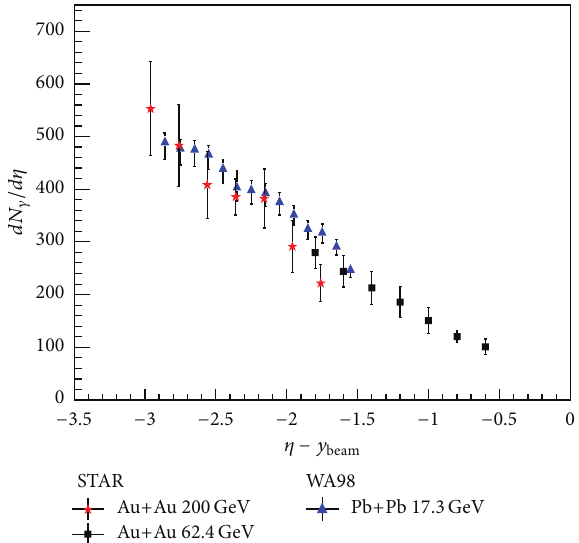
Figure 30: Photon multiplicity density normalized per participant pair for different energies shown in the projectile rest